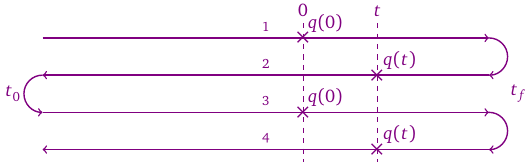
Figure 3: Contour-ordered correlator for 〈 q ( t ) q ( 0 ) q ( t ) q ( 0 )